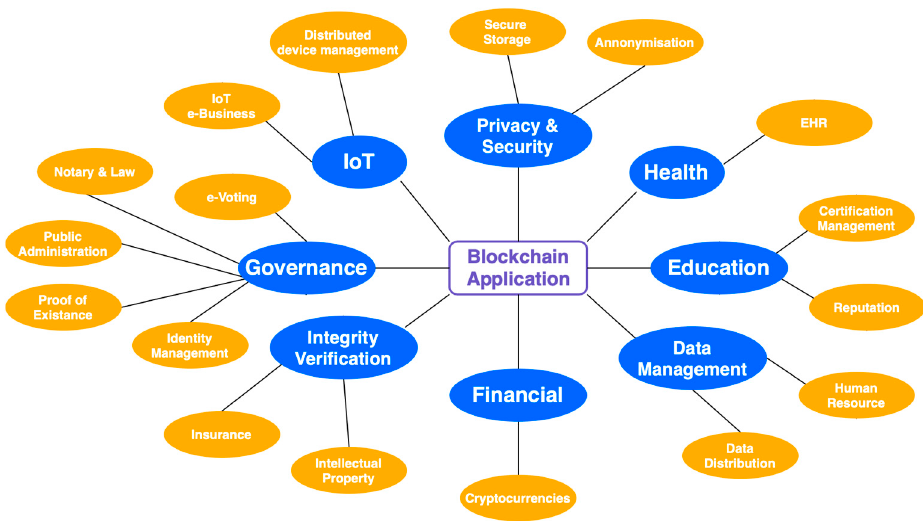
Figure 3. Blockchain-based applications.